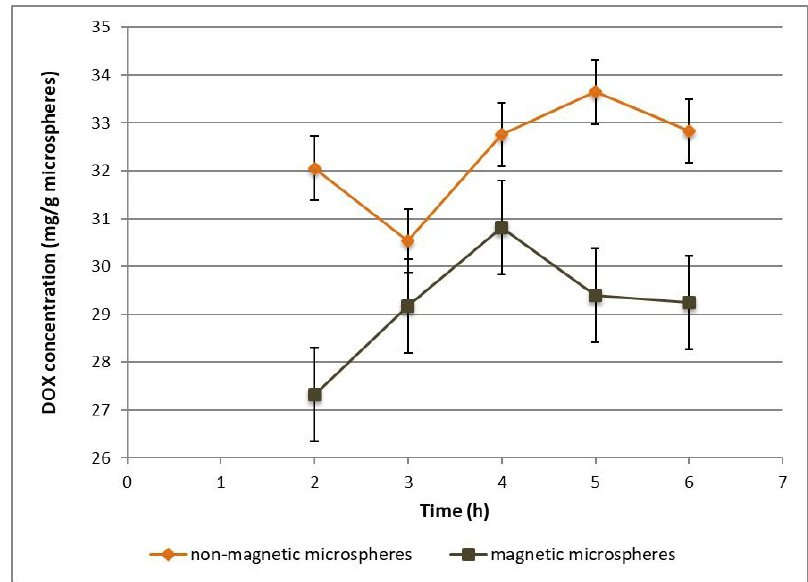
Figure 6. Doxorubicin loading on microspheres based on gelatin and fructose (non-magnetic microspheres) and microspheres based on gelatin, fructose magnetite obtained by ferrous chloride (magnetic